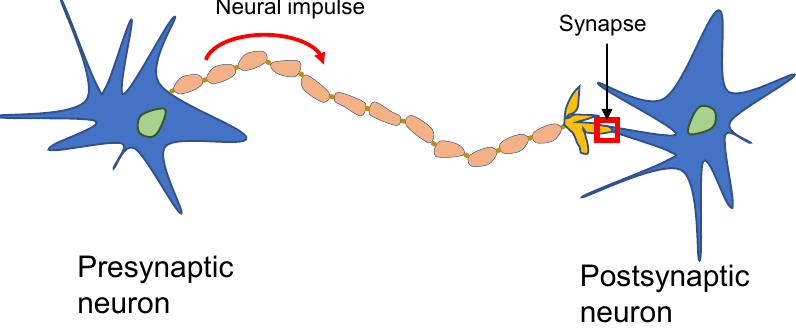
Figure 1. A neural network of the human brain.